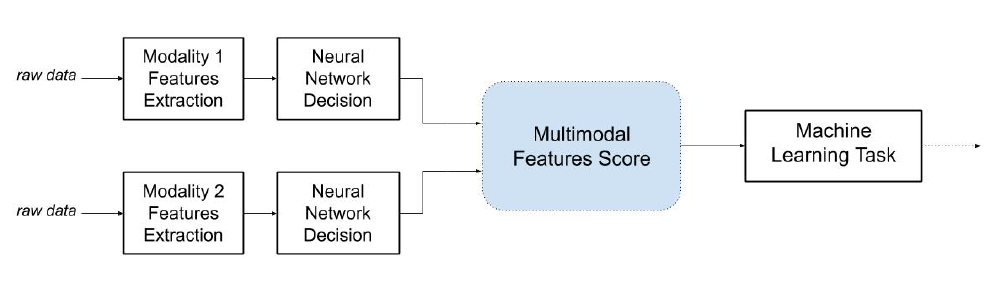
Figure 9. General scheme for late fusion. The outputs of unimodal analyses are used to learn separate scores for a concept. After the fusion procedure, a final score is learned for the